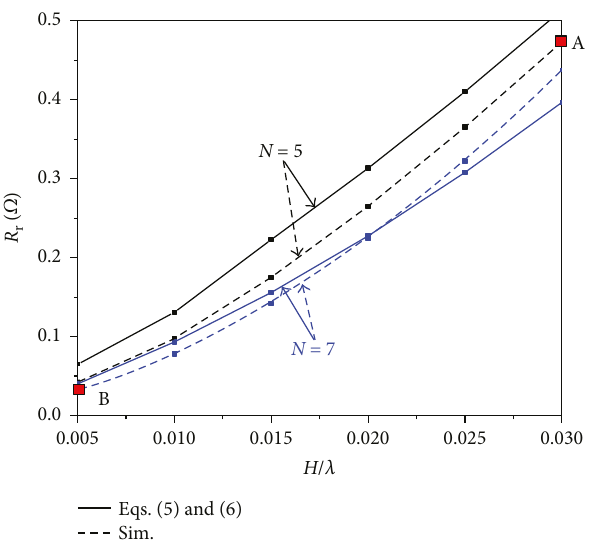
Eqs. (5) and (6) Sim. Figure 3: Comparison of NMHA radiation resistance in free space between the equation results and the simulation results.